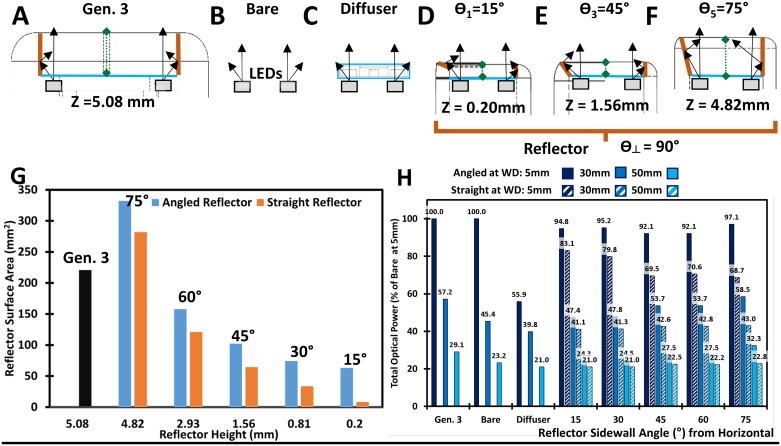
Representative graphical simulations of differences in light ray path, beam shape, and beam intensity between reflector designs with varying sidewall angles using the integrated white LEDs.Zemax Ray Tracing and Solidworks digital drafting programs were used to simulate the effect if any of different integrated reflector cone designs with the Generation 4 Pocket Colposcope. Simplified diagrams of simulation set up are shown for (A) Generation 3, (B) Bare LEDs, (C) Diffuser Window, (D) Reflector at 15° from the indicated axis (perpendicular to the imaging axis) (E) Reflector at 45°from indicated axis, and (F) Reflector at 75° from indicated axis. The surface area of the reflectors is shown as a function of height and angle and the total optical power for a working distance of 5, 30 and 50 mm (G). Angling the reflector (light blue) netted a gain of 20–30% surface area when compared to the matched height straight reflector (orange). Similarly, (H) we noted that the 75° angled reflector performed the best out of all angled (solid blues) or straight (hatched blues) reflectors, at all working distances. For both Pocket Colposcopes the expected field of view is roughly equivalent to the respective working distance.